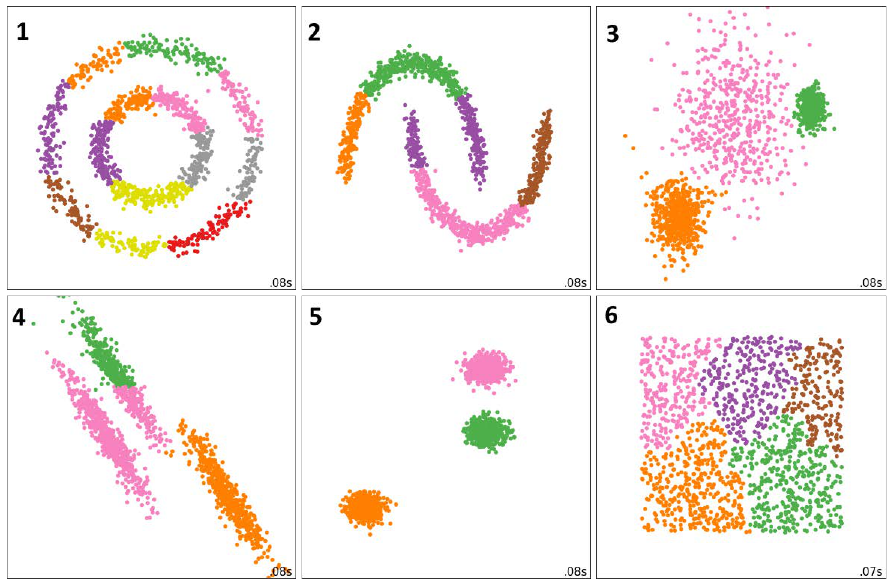
Figure 1. Results of the proposed approach made on datasets from